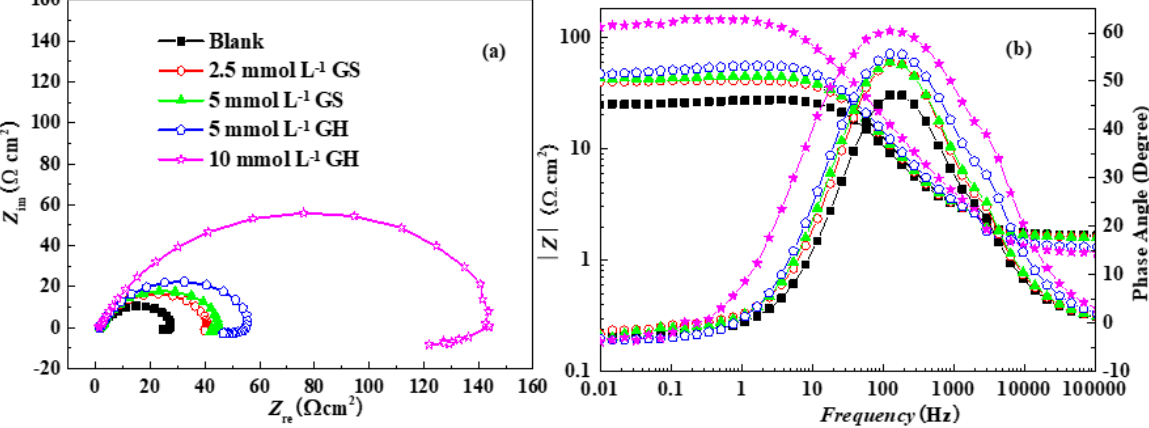
Figure 2. EIS of the electrodes in 0.5 mol L − 1 H 2 SO 4 solution without and with various amounts of glucosamine salts: ( a ) Nyquist diagram; ( b ) Bode plots.